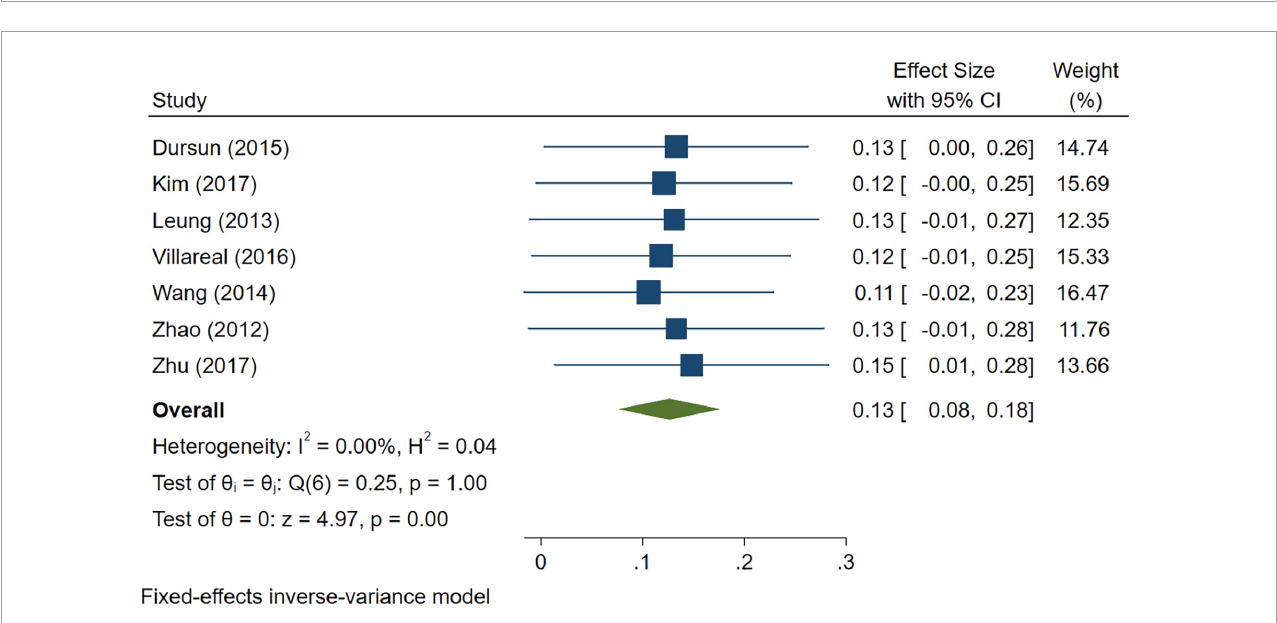
FIGURE8 Forest plot of pooled Hedge’s g depicting high IL-6 concentration in mild cognitive impairment (MCI) samples compared to